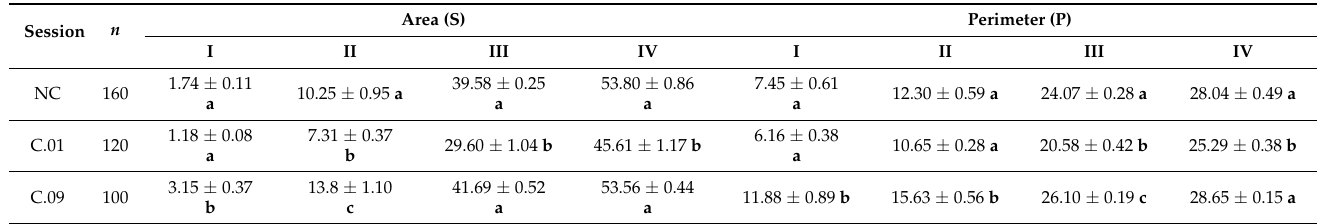
Table 1. The average areas (S) and perimeters (P) of all four damage zones in three experimental sessions.